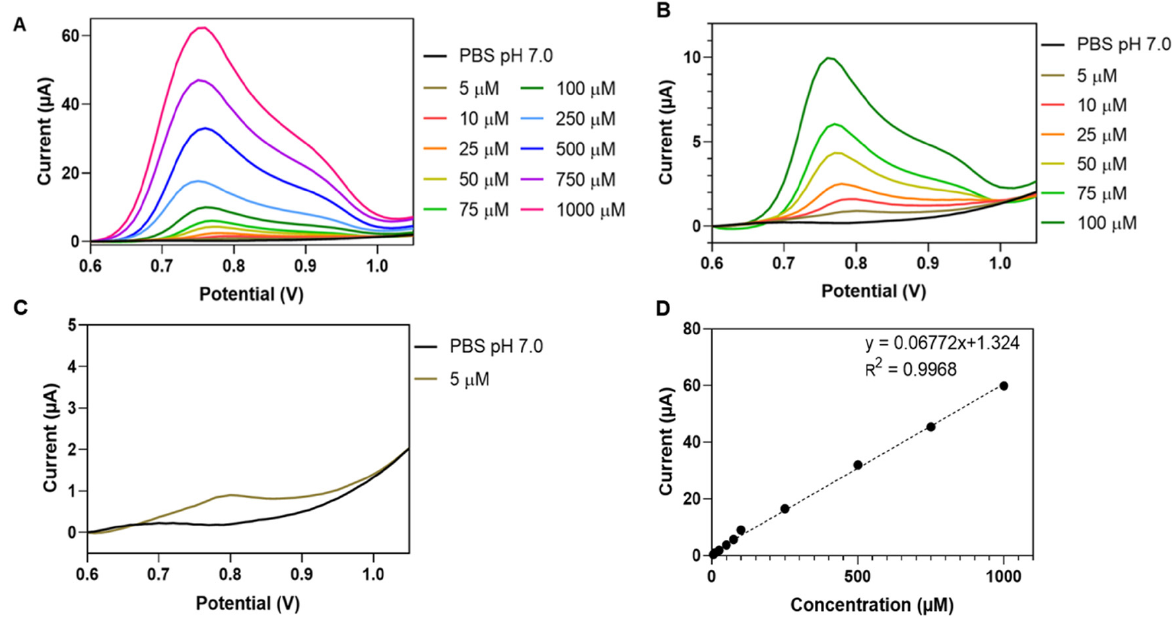
Figure 2. Differential pulse voltammograms (DPVs) from a 3-mm-diameter BDD electrode in 0.1 M PBS pH 7.0 and 0.1 M PBS with 5–1000 μ M 4NP ( A ). Zoomed DPV display for 5–100 μ M 4NP ( B ) and 5 μ M 4NP ( C ). Calibration plot (mean 4NP DPV peak current values from triplicate repetitions vs. actual 4NP level) for 4NP differential pulse voltammetry at BDD disk working electrodes ( D ). Note: Error bars in ( D ) are smaller than the symbols of the data points. DPV scan speed was 0.05 V s-1 while the pulse amplitude, step and width were 0.2 V, 0.01 V and 0.02 s.